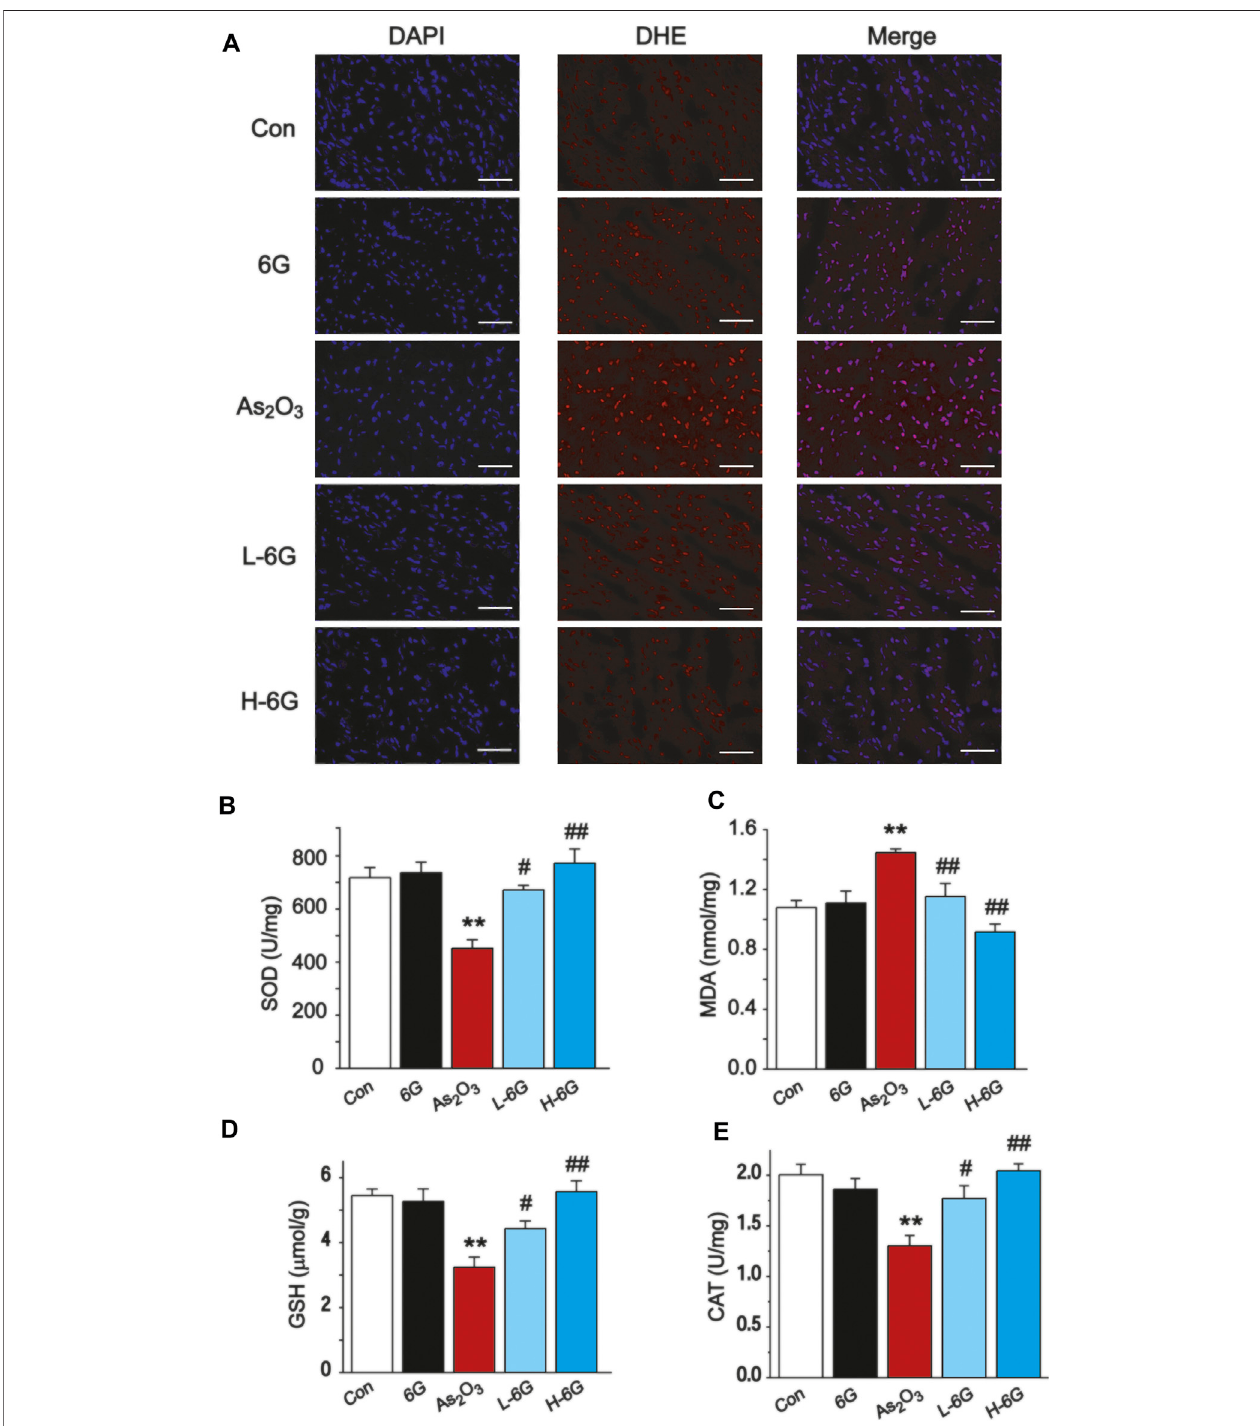
FIGURE6| Effectof6Gonoxidativestressincardiactissues. (A) RepresentativeROS fl uorescenceimagesineachgroup(400×,scalebar=50 µm).Theeffectsof 6GonthelevelsofSOD (B) ,MDA (C) ,GSH (D) andCAT (E) inmyocardialtissuesofeach group.Dataarepresentedasmean±SEM, n =3.** p < 0.01asincomparison to the Con group and # p < 0.05, ## p < 0.05 as in comparison to the As 2 O 3 group.